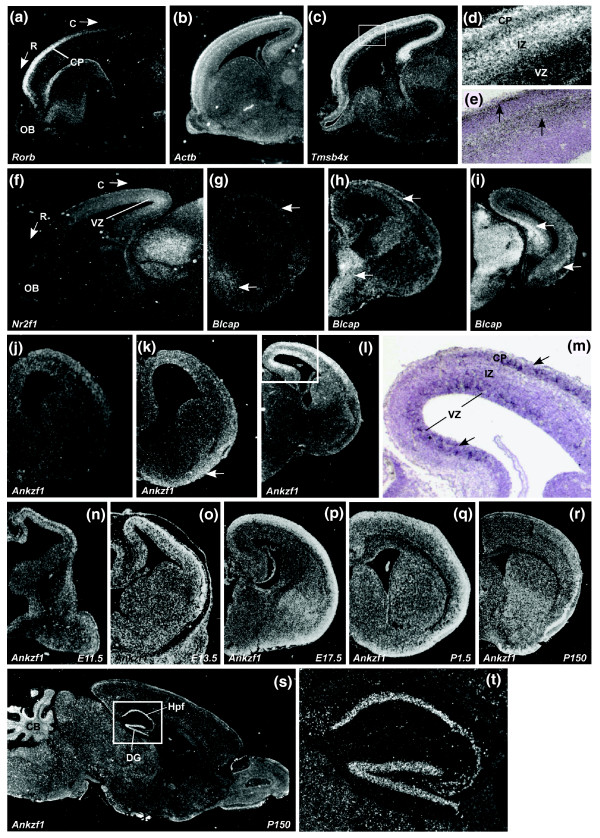
In situ RNA hybridization of selected R versus C regions of E15.5 DETs. ISH was performed on (a-m) E15.5 and (n-t) E11.5 to P150 brains. (g-m) Coronal sections that are generated from the rostral to caudal axis; (a-f, s-t) sagittal sections. Micrographs of higher magnification are presented directly after any micrographs with an inset box (d-e, m, t). All micrographs are in dark-field except for (e, m), which are bright-field micrographs. C: caudal; CB: cerebellum; CP: cortical plate; DG: dentate gyrus; HPf: hippocampal formation; IZ: intermediate zone; OB: olfactory bulb; R: rostral; VZ: ventricular zone. Arrows show the region with expression or silver grains.